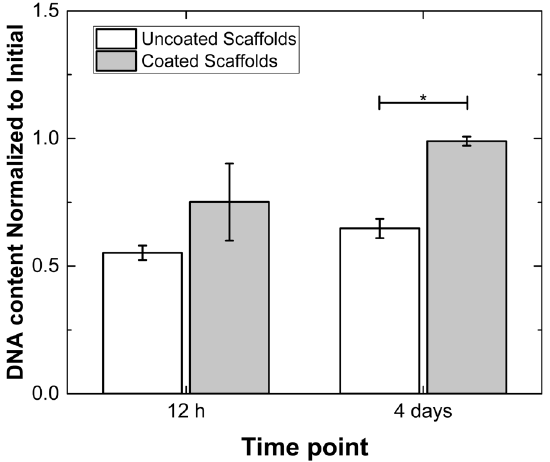
Figure 9. DNA content comparison between uncoated and Hap-coated SS woven lattice after culturing for 12 h and four days ( n = 3 samples per group at each time point), (mean ± SE); significance determined by two-tailed Student’s t -test, P = 0.0026.